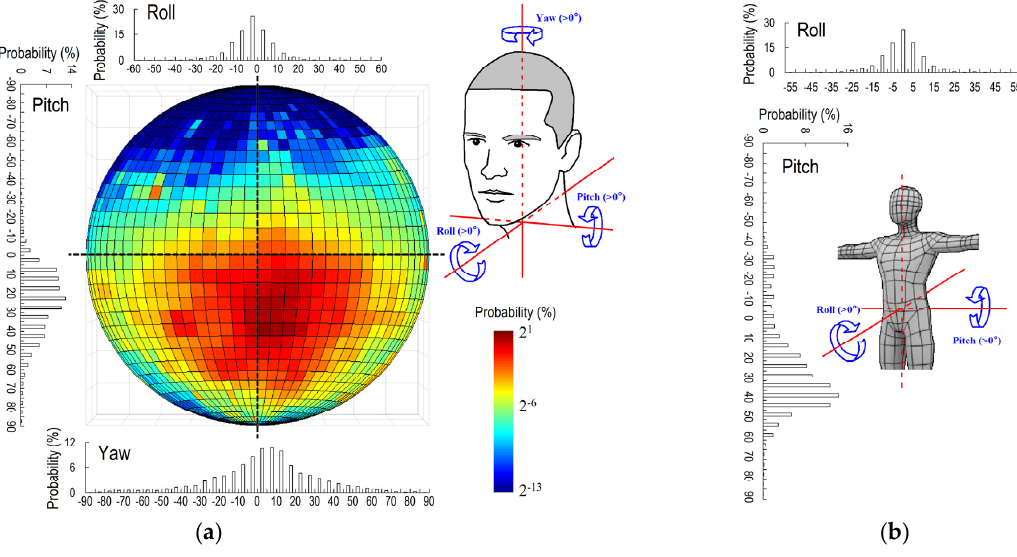
Figure 4. Indoor human behavior in terms of head and body motion. ( a ) Head motion; ( b ) Body motion. (Yaw of head is relative to the body; pitch and roll of head and all body motions are relative to the ground.)